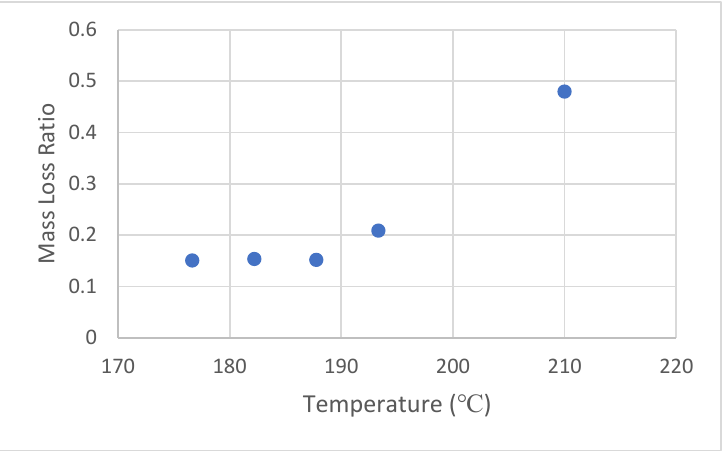
Figure 9. MLR for 124 kGy resins held at various temperatures for 10 min under 6672 N force.